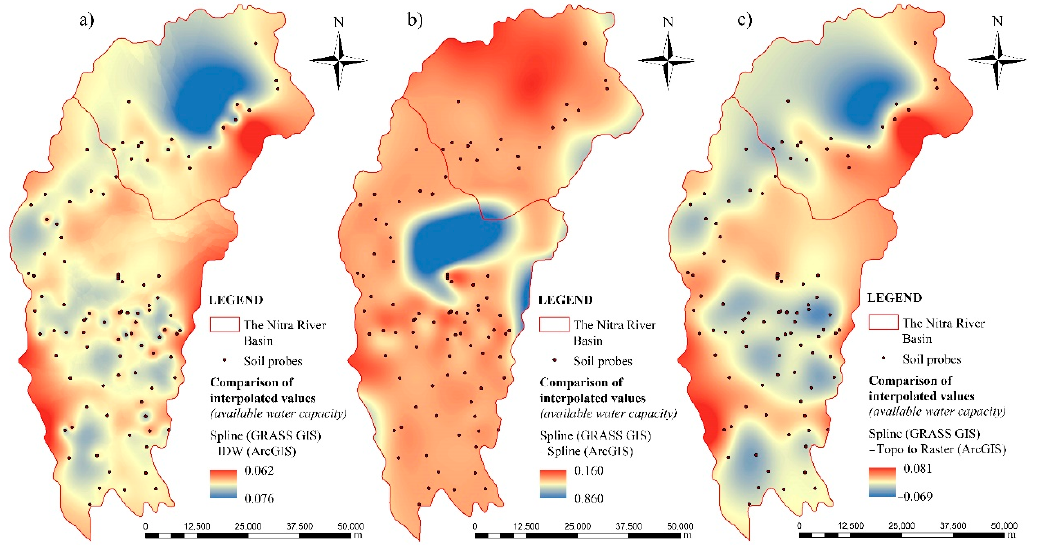
Figure 5. Comparison of GRASS GIS Spline with other interpolation methods for available water capacity: ( a ) Spline (GRASS GIS)—IDW (ArcGIS); ( b ) Spline (GRASS GIS)—Spline (ArcGIS); ( c ) Spline (GRASS GIS)—Topo to Raster (ArcGIS).